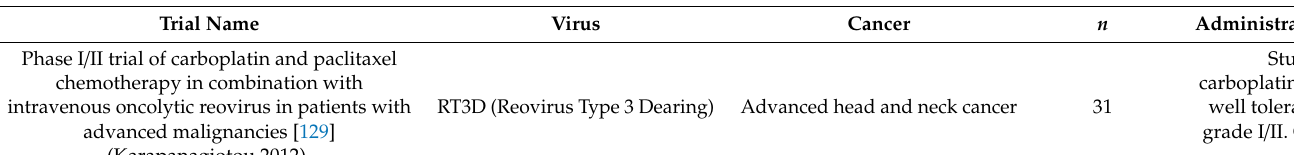
Table 4. Summary of oncolytic virus use in Phase I / II